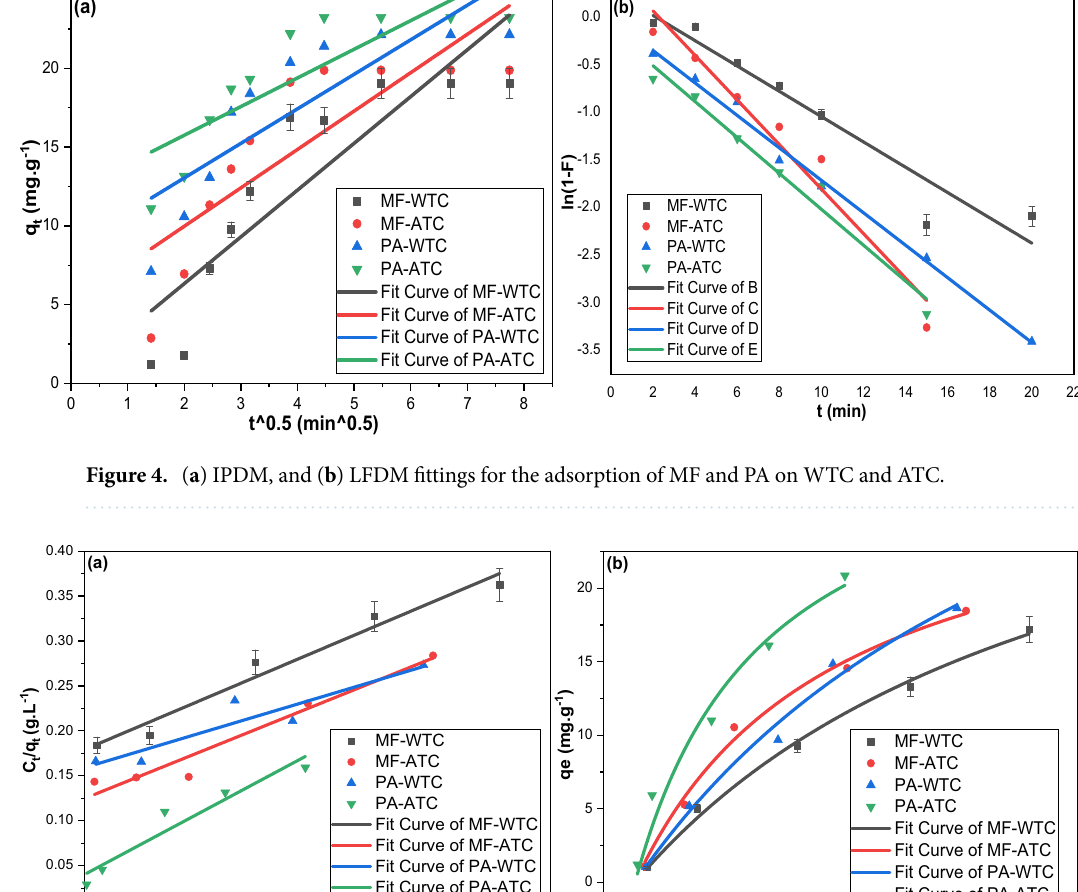
Fit Curve of MF-WTC Fit Curve of MF-ATC Fit Curve of PA-WTC Fit Curve of PA-ATC